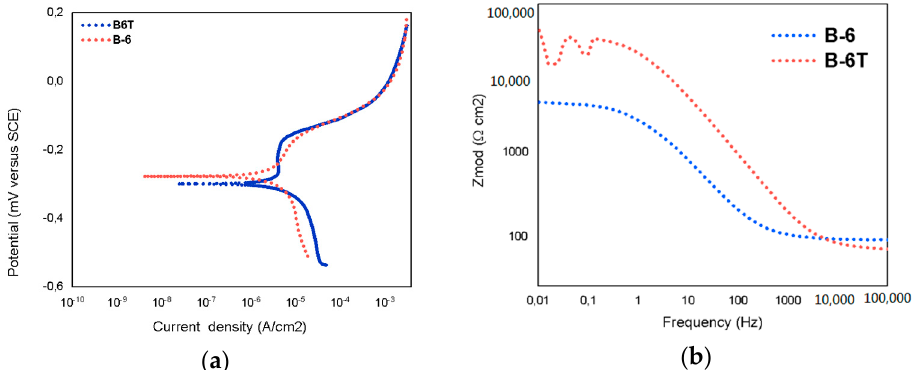
Figure 16. Electrochemical test. ( a ) Potentio-dynamic polarization curves; ( b ) Bode spectra for Cu–Al